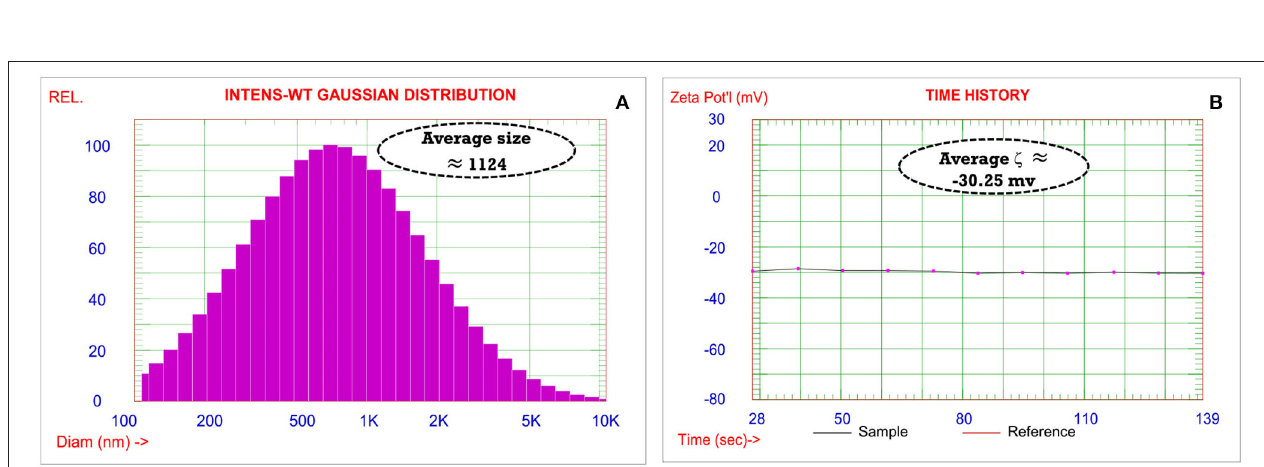
FIGURE 2 | (A,B) SEM at low and high magnifications and (C,D) EDX of the commercial Zn fertilizer.